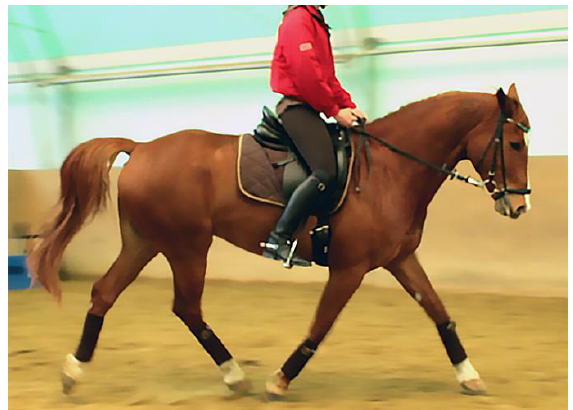
Figure 2. Head-neck-position during the ridden test.